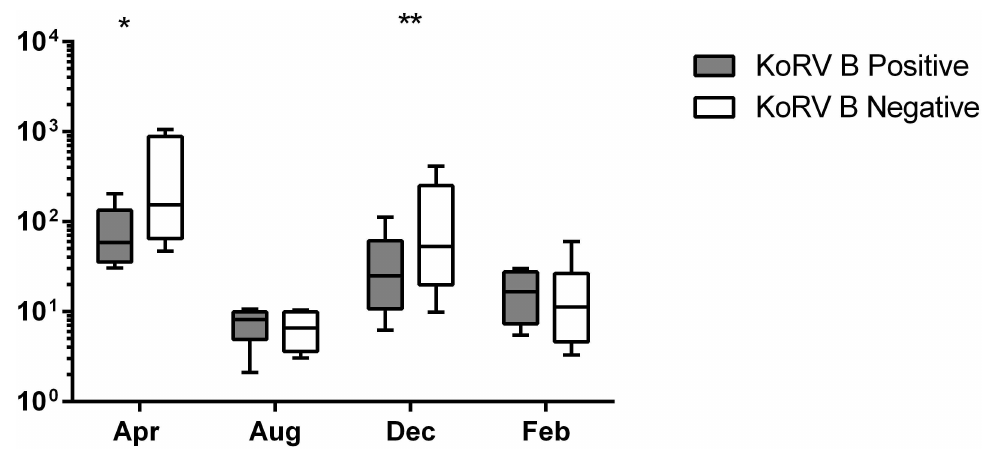
Fig 6. IL10 baseline production in KoRV B positive and negative groups. * p < 0 . 05 , ** p < 0 . 01 Mann Whitney U. Results are relative expression of cytokine levels compared to reference genes calculatedusing the Δ Cq method [43]. Box representsthe 25 th to 75 th percentiles, middle line is median and whiskers are the minimum to maximum